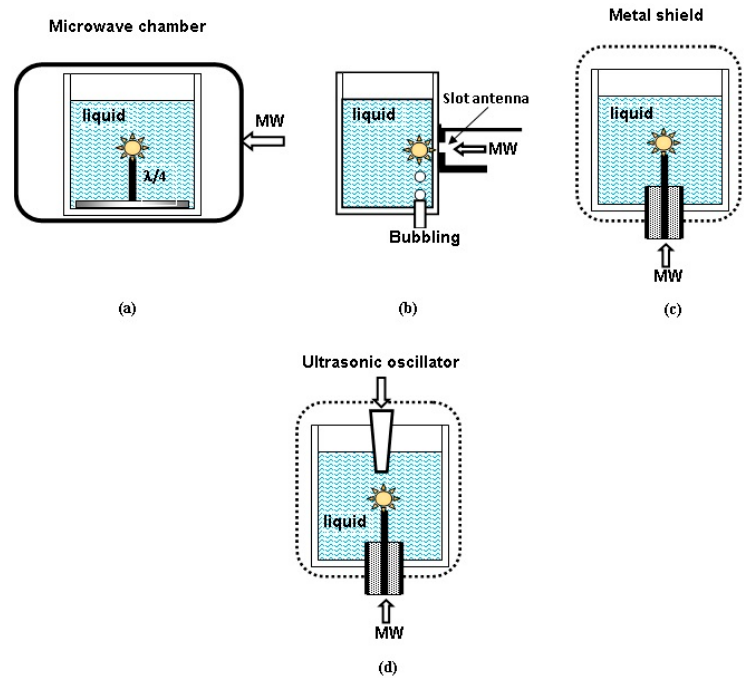
Figure 2. Schematics of different types of microwave discharges in liquids: ( a ) discharge on the base of quarter-wavelength antenna; ( b ) discharge on the base of slot antenna; ( c ) discharge with energy input through the coaxial line; and ( d ) microwave discharge in combination with ultrasonic radiation.